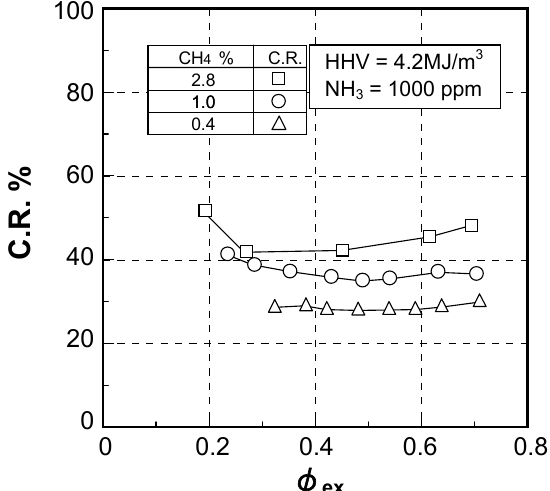
concentration on NOx emission 4